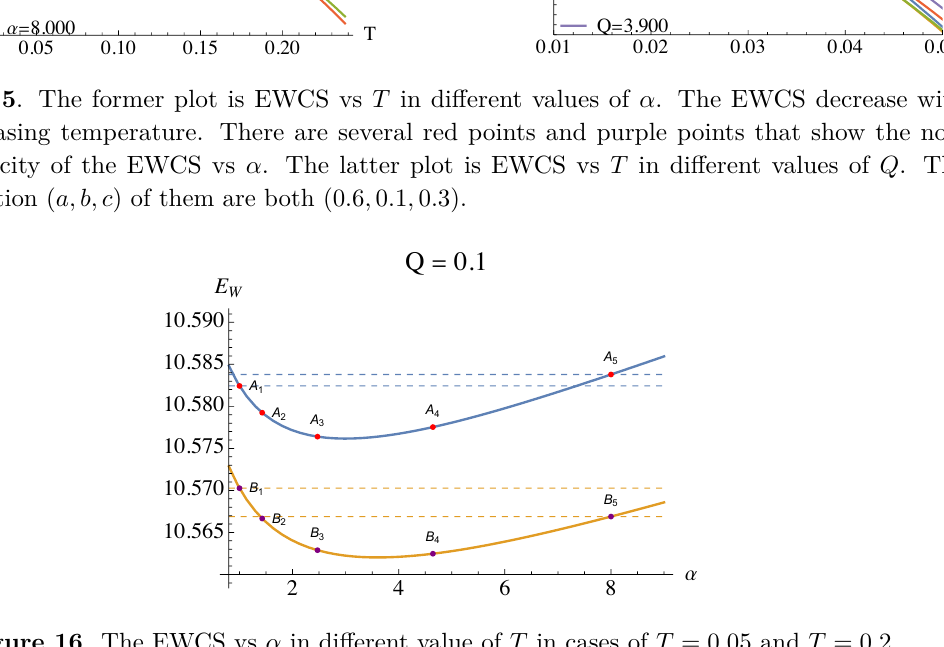
Figure 16 . The EWCS vs α in different value of T in cases of T = 0 . 05 and T = 0 . 2